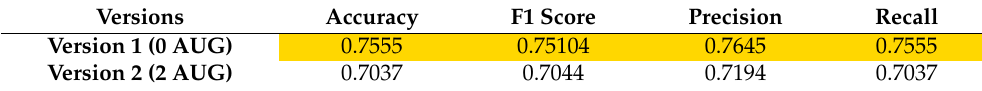
Table 18. Metrics of the RF classification algorithm obtained with the second model. Each column refers to a different metric, as defined in Section 2.4.2. Each row refers to a different version of the model.